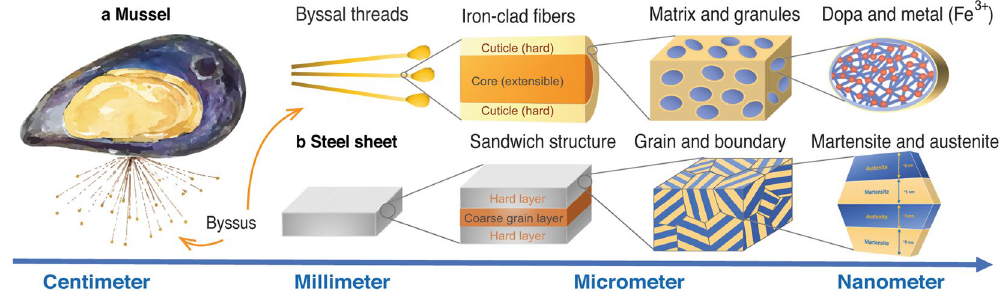
Figure 1. Design concept: the overall architecture of the hierarchical steel, as compared to that of strong and tough natural byssal threads. ( a ) Sandwich structures of byssal threads and ( b ) the hierarchical steel developed in this work. On the micro-scale, the threads are made of a matrix and granules which vary in cross-linking density, the granules containing a higher cross-link density than the matrix; this controls the difference in local mechanical properties. From the micro-scale point of view, the hierarchical steel is comprised of a hard layer and a coarse-grained layer. At the nano-scale, there are two compositions, dopa and metal (Fe 3 + ), that comprise a single granule. At the same dimension, our hierarchical steel has a graded dual-phase structure consisting of nano-scale martensite and nano-scale austenite, which are distributed as alternating lamellar, ~5 to 6 nm thick, inside each grain of the